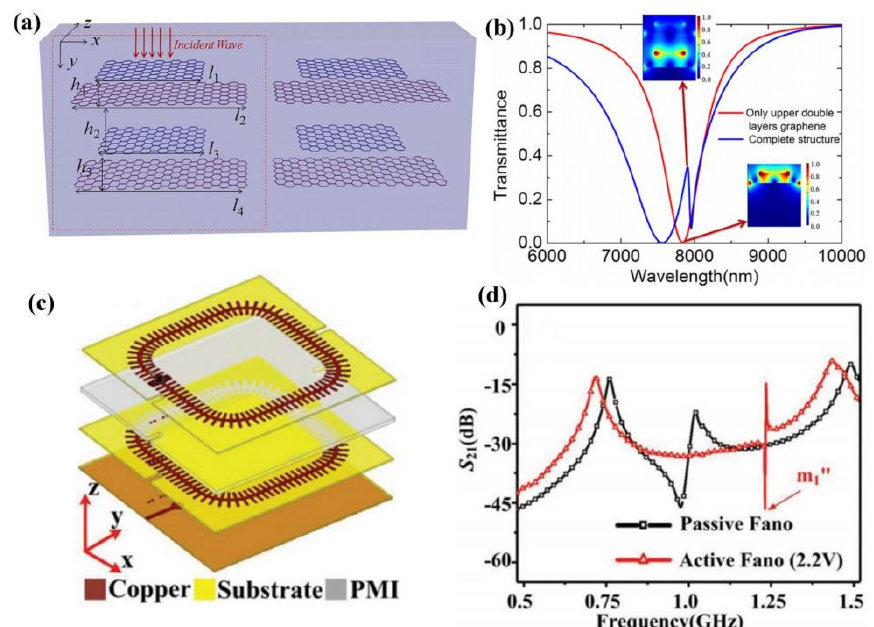
Figure 5. ( a ) Schematic diagram of the two double–layer graphene–based plasmonic structures. Adapted with permission from Ref. [91]. Copyright (2018), the authors. ( b ) The transmission spectra of this terahertz graphene–layered metamaterial structure. ( c ) The detailed diagram of the active Fano resonance structure. Adapted with permission from Ref. [95]. Copyright (2019), Wiley–VCH Verlag GmbH & Co. KGaA, Weinheim. ( d ) The measured transmission coefficients S 21 of the passive and active Fano resonance structures.